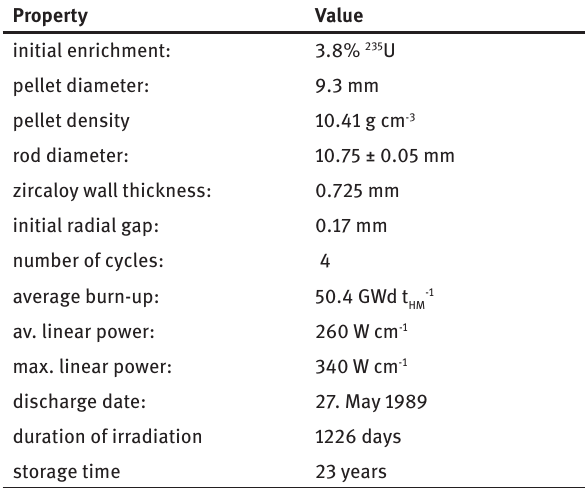
Table 1: Characteristics of the fuel rod segment N0204 KKG-BS studied by KIT [13].